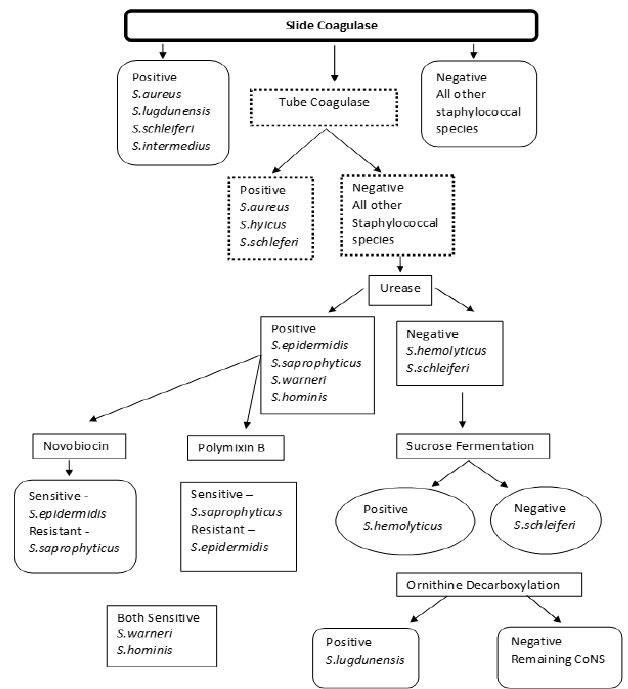
Fig. 1. Flow chart for speciation of